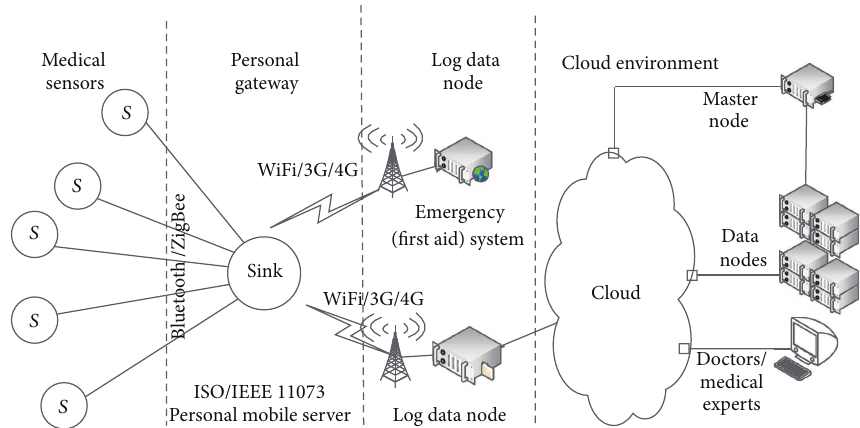
Figure 2: The X73 uHealth system